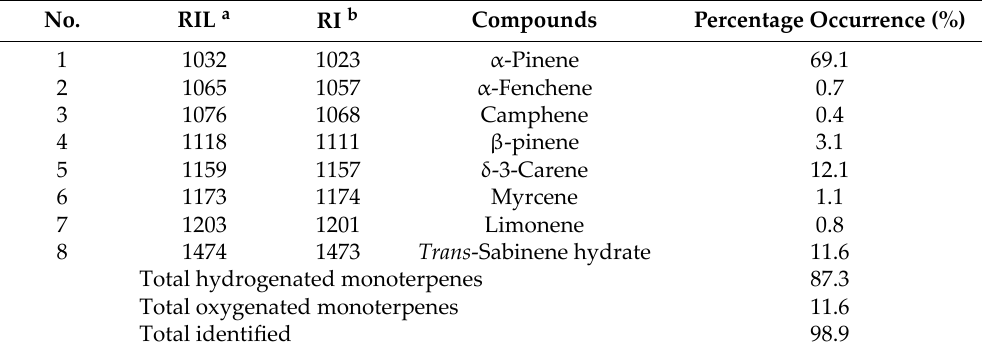
Table 1. Chemical composition of essential oils from fruit of Chamaecyparis obtusa .